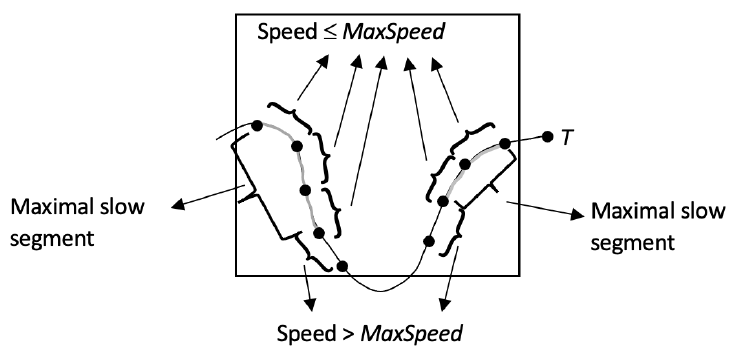
Figure 5. Trajectory with two maximal slow segments in a cell of a spatiotemporal scenario.